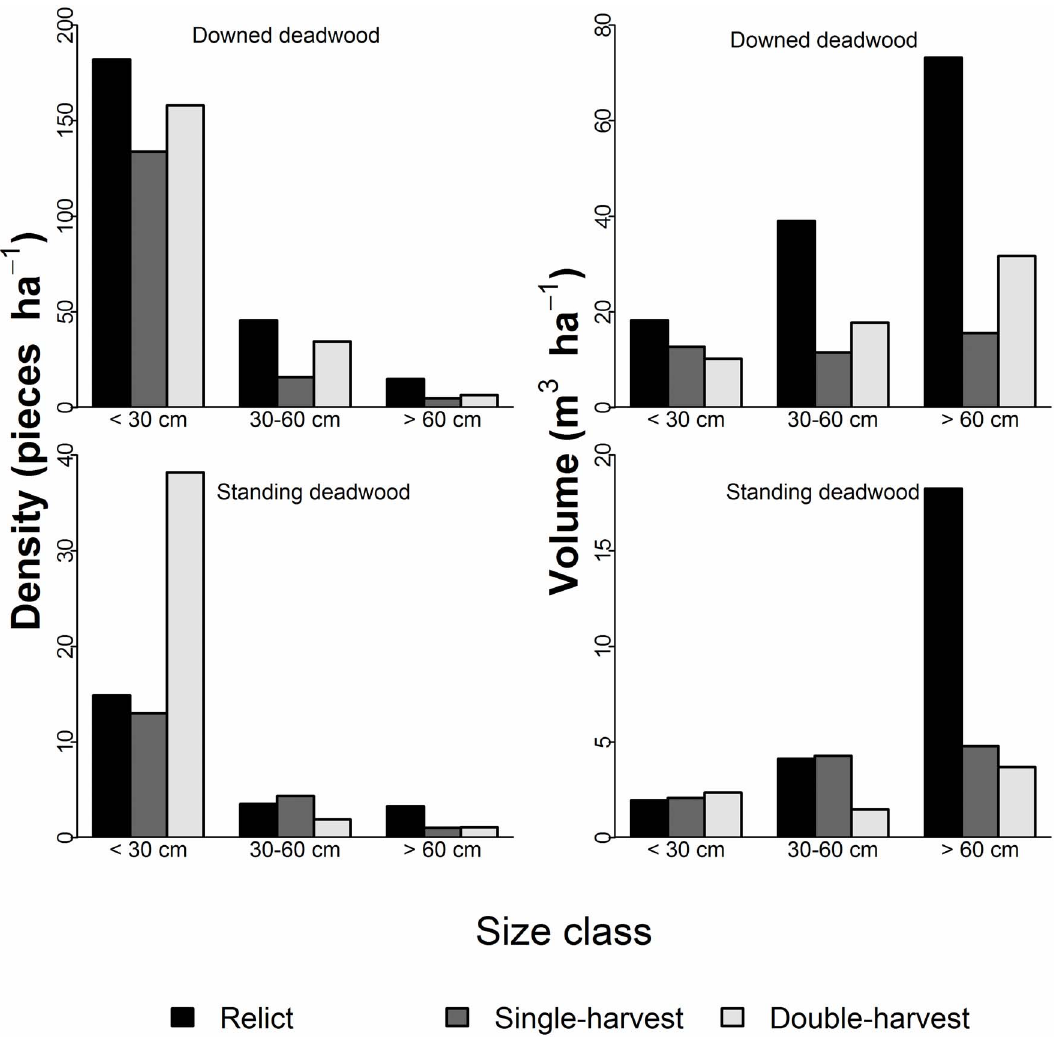
Figure 2. Coarse woody debris size class summaries. Downed deadwood (DDW; top row) and standing deadwood (SDW; bottom row) number of pieces ha 2 1 and volume ha 2 1 by size class for relict, single-harvest, and double-harvests stands. Size classes were defined as diameters of # 30 cm, . 30 cm and # 60 cm, and . 60 cm; DDW diameter was based on large end diameter, and we used diameter at 1.37 m (DBH) for SDW.